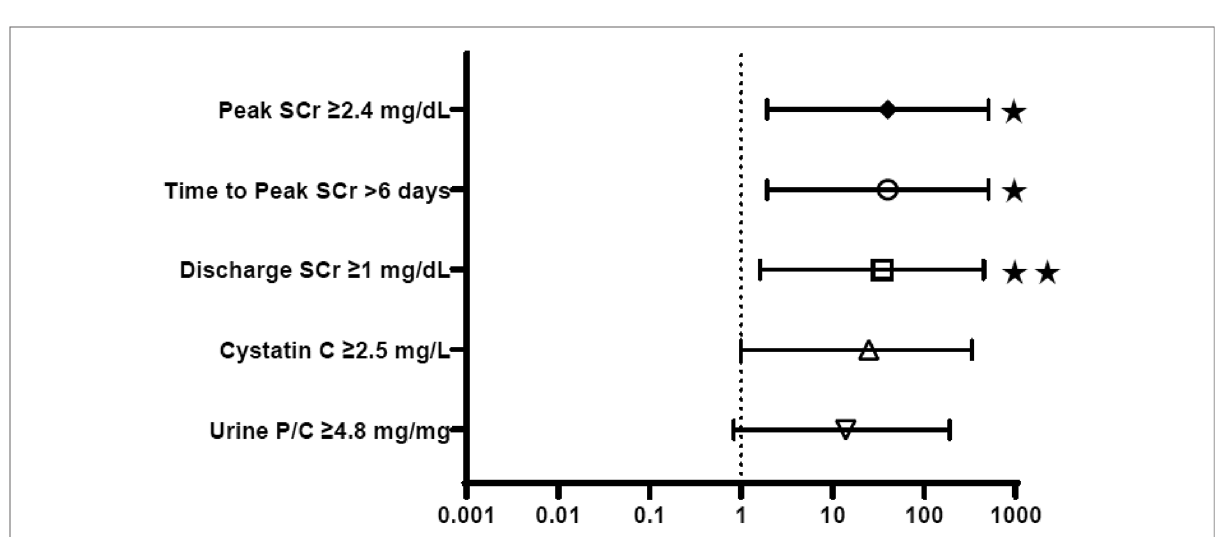
FIGURE 3 Neonatal biochemistry: odds ratios for prediction of CKD stage 4 – 5 in the fi rst year of life. SCr, Serum creatinine; U P /C, Random urine protein: creatinine. * p <0.05, ** p